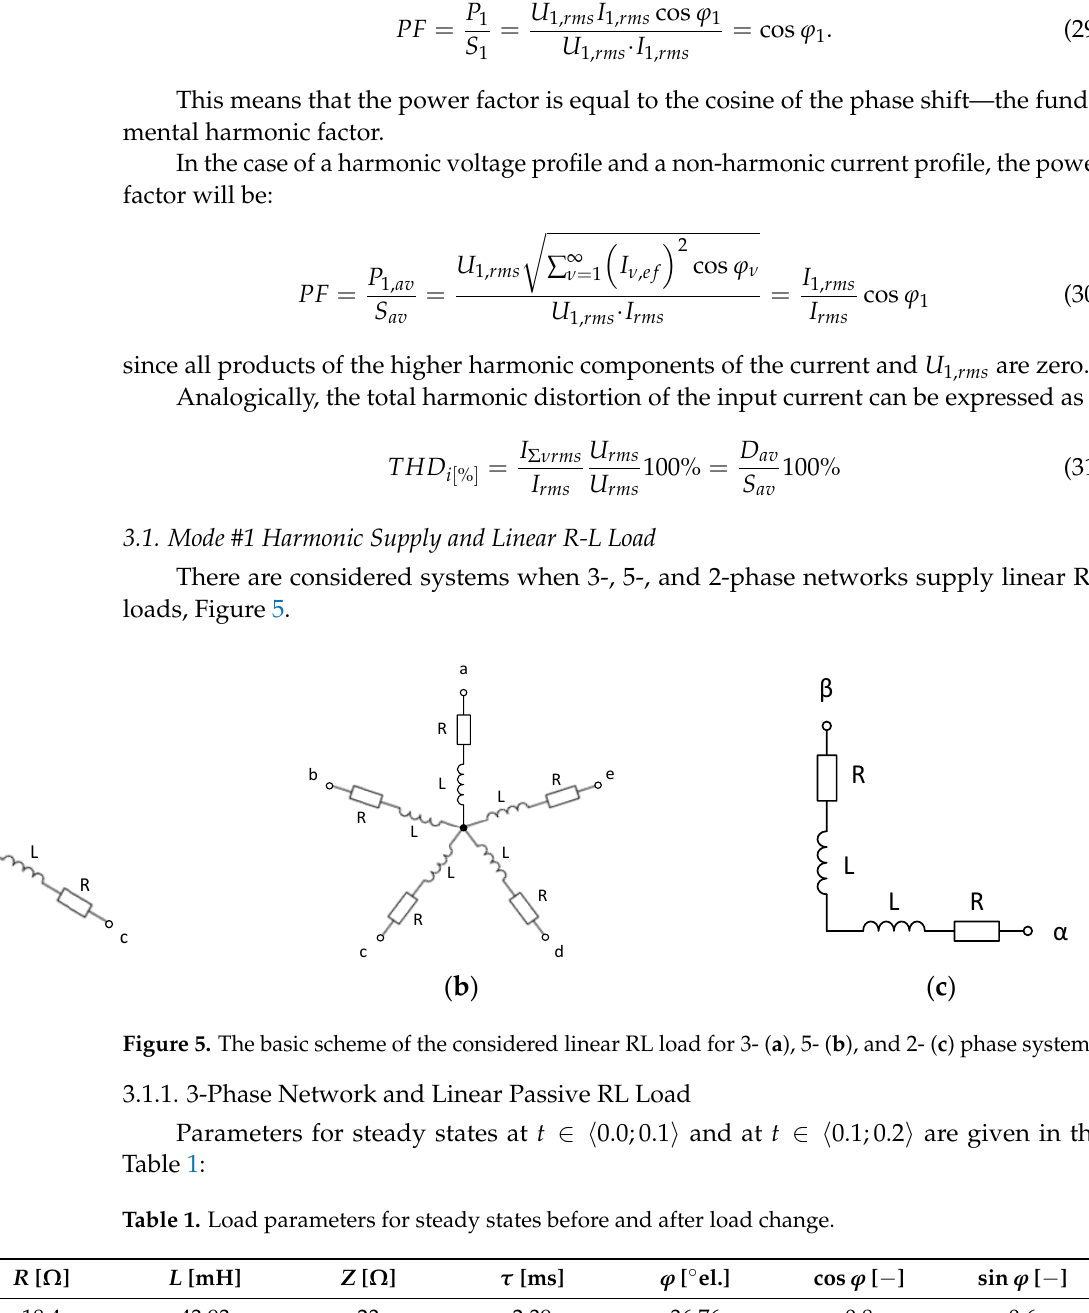
𝑈 = 230 𝑉, 𝑓 = 50 Hz, 3 − phase system . 𝑟𝑚𝑠